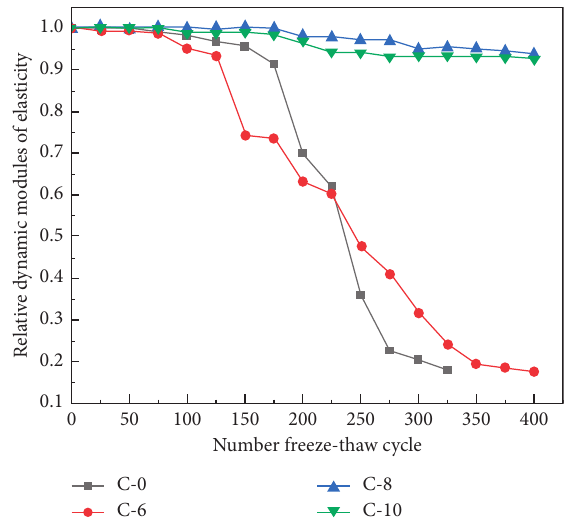
Figure 7: Relative dynamic modulus of elasticity of concrete.